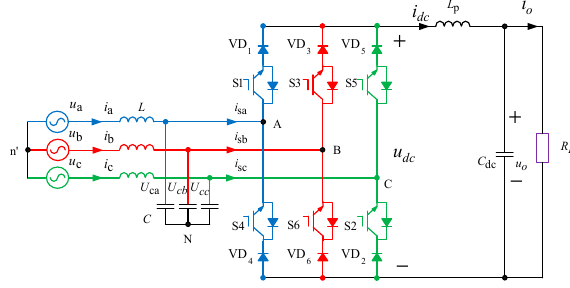
Figure 1. Schematic diagram of current-source converter.